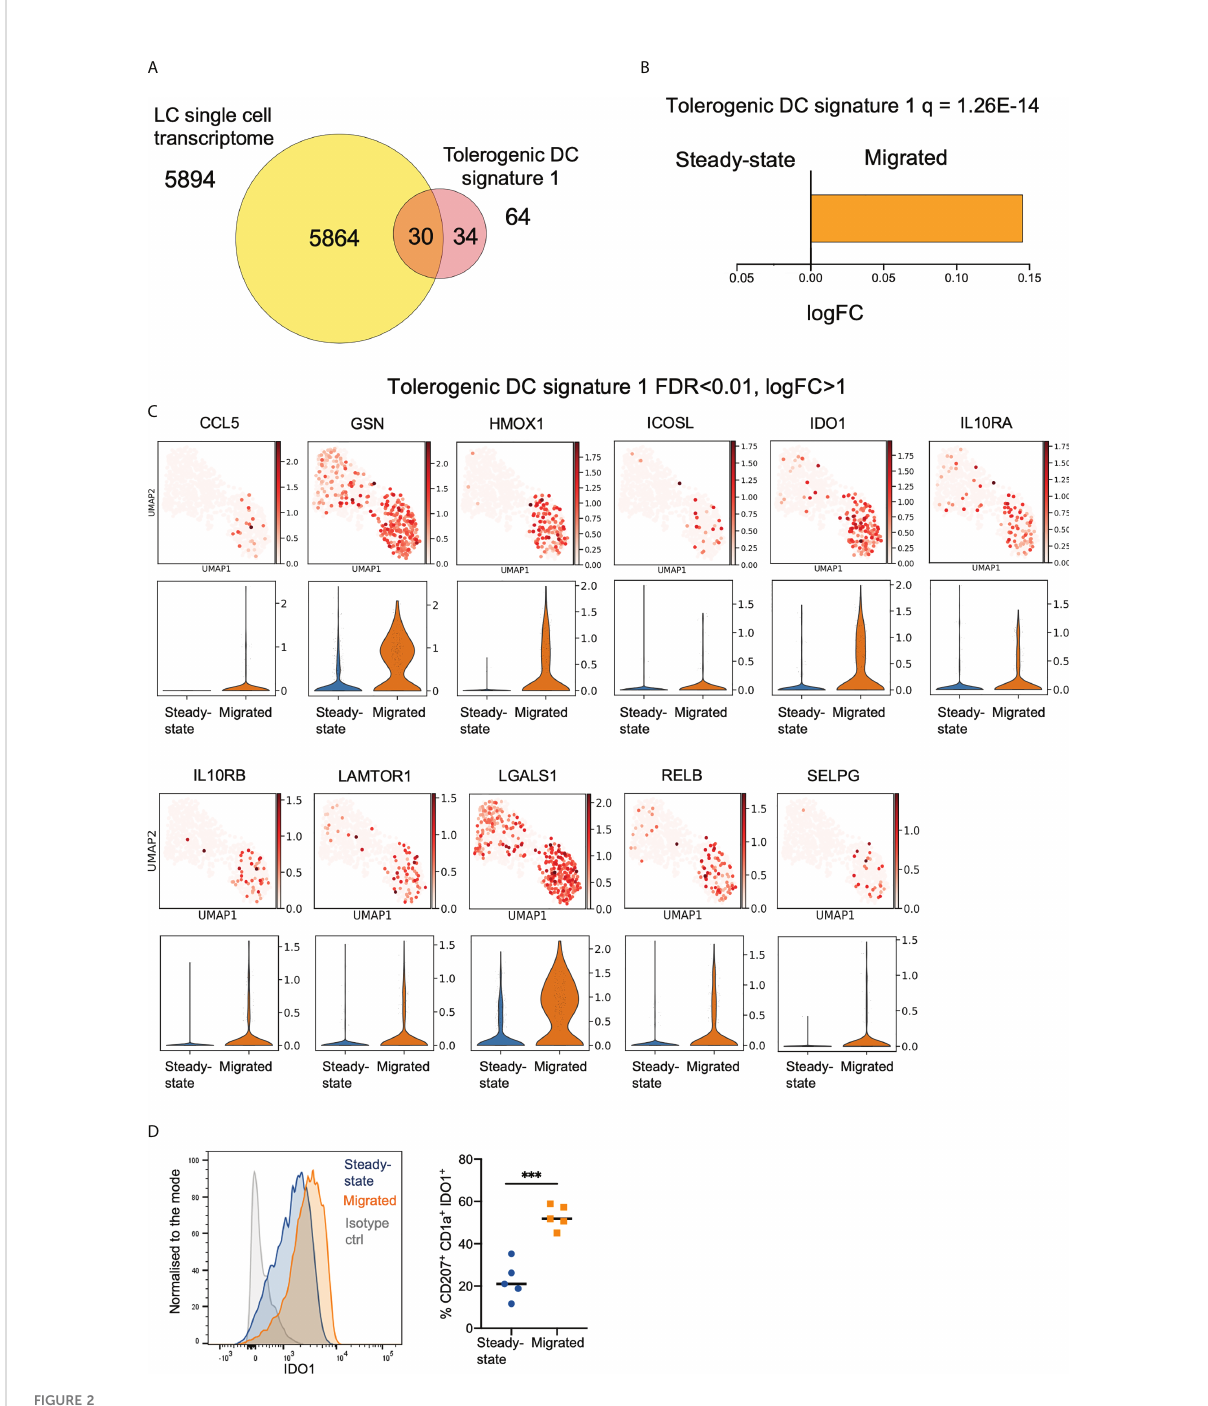
FIGURE 2 Migration of LCs from the epidermis enhances their immunoregulatory transcriptional programming. (A) Venn diagram displaying the number of genes from tolerogenic gene signature 1 (tol 1), curated from literature exploring genes associated with DC or macrophage tolerogenic function, within the whole LC single cell dataset. (B) Gene Set Variation Analysis (GSVA) displaying enrichment of tol 1 in the LC populations. FDR corrected p-values and logFC are displayed. (C) Violin plots and UMAP marker plots displaying the expression of genes within tol 1 amongst steady-state and migrated LCs (FDR corrected p-values <0.01, logFC>1). (D) Flow cytometry analysis of IDO1 protein expression in steady-state and migrated LC extracted by 48 hour culture of epidermal sheets. n=5 steady-state and migrated independent LCs versus isotype control (grey), n=4 migrated LCs.